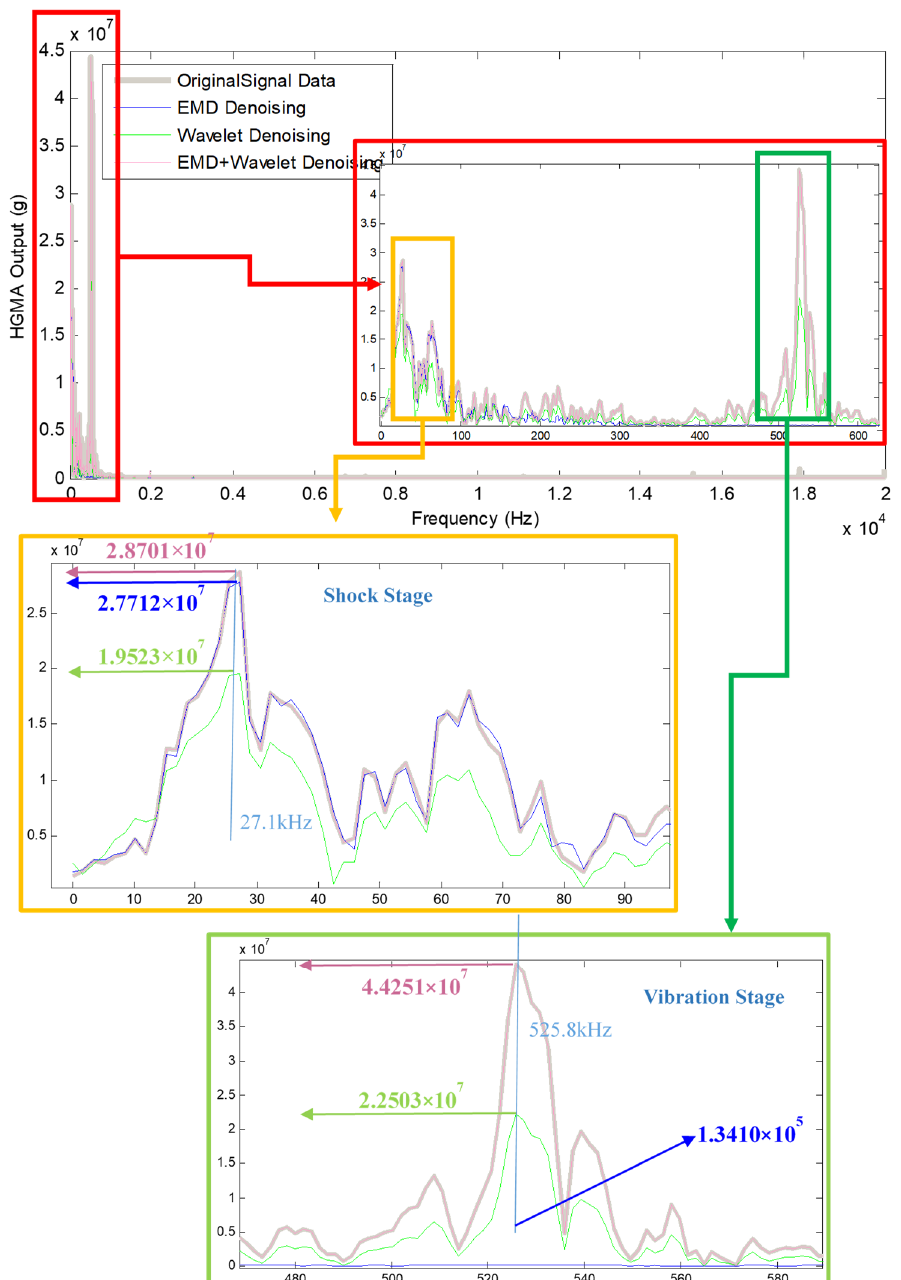
Figure 8. Frequency characteristic of original signal and denoising results.